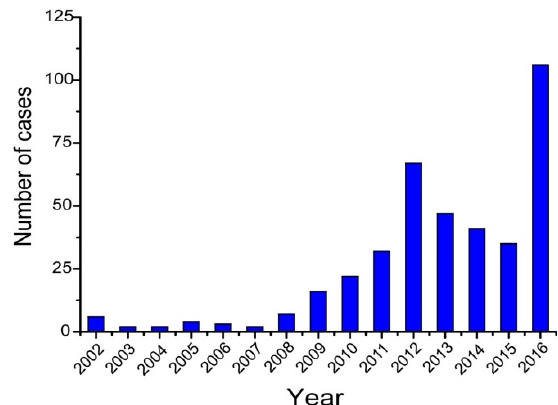
Figure 1. Number of melioidosis cases by year identified during surveillance, Hainan, China, 2002–2016.